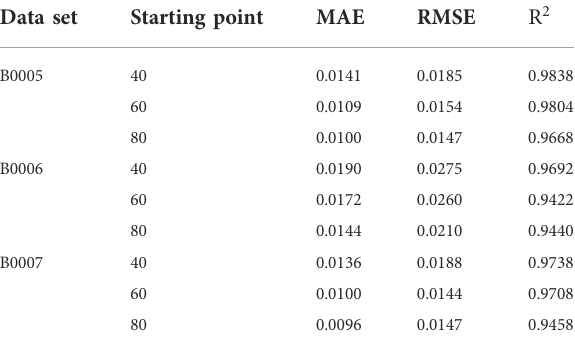
TABLE3Predictionresultsofdifferentpredictionstartingpointsinthe NASA data set. Data set Starting